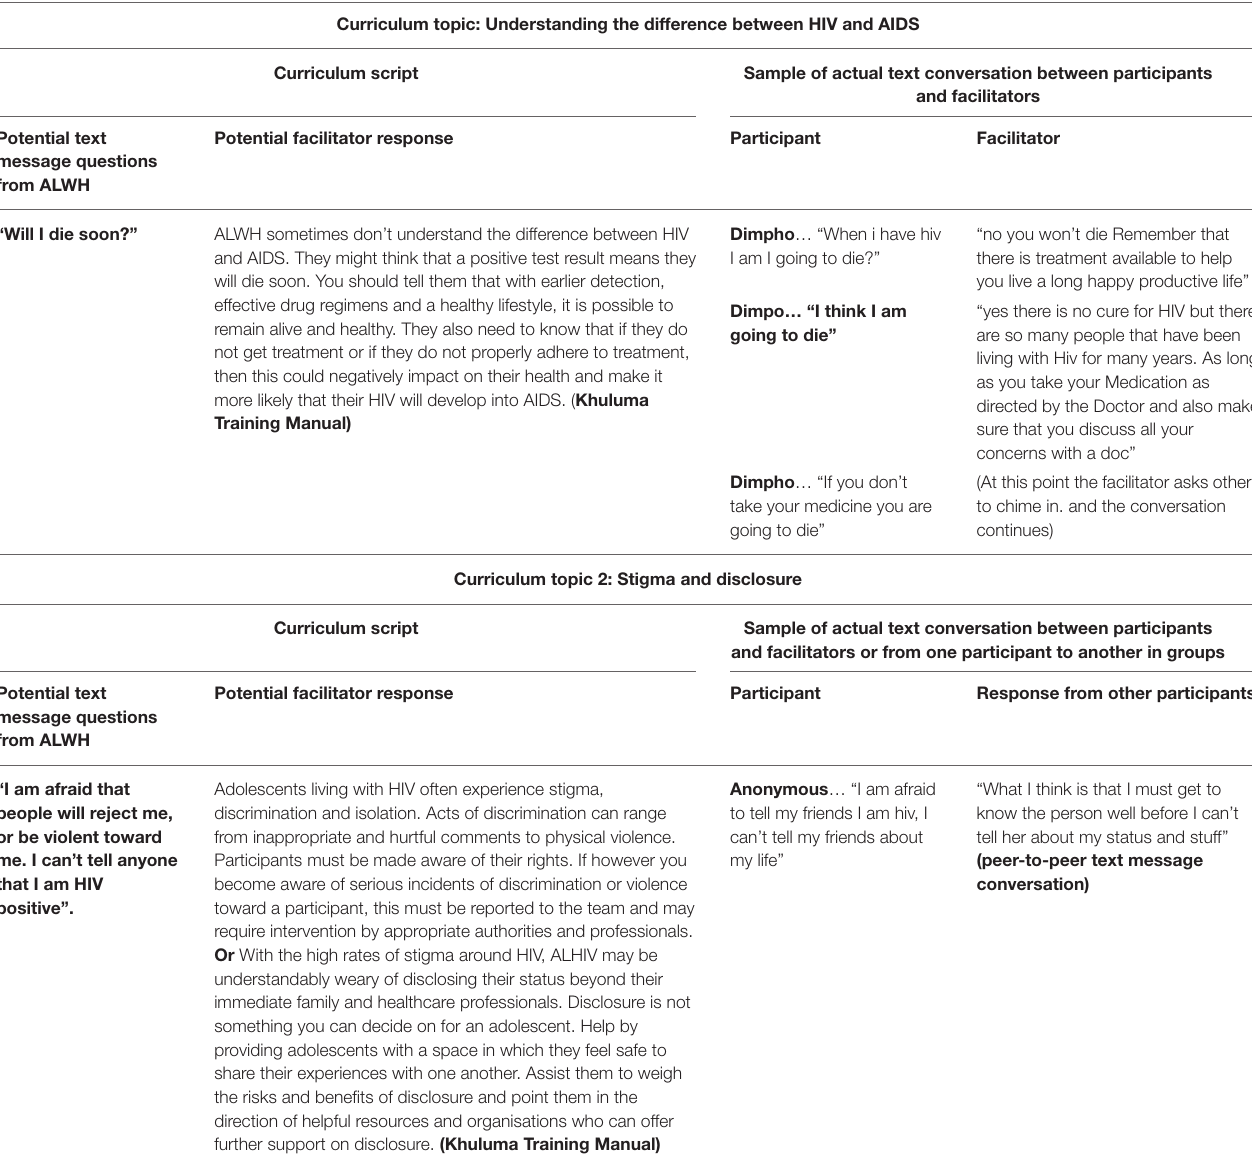
TABLE 1 | Curriculum script of potential text messages and excerpts of actual text message conversations. Curriculum topic: Understanding the difference between HIV and